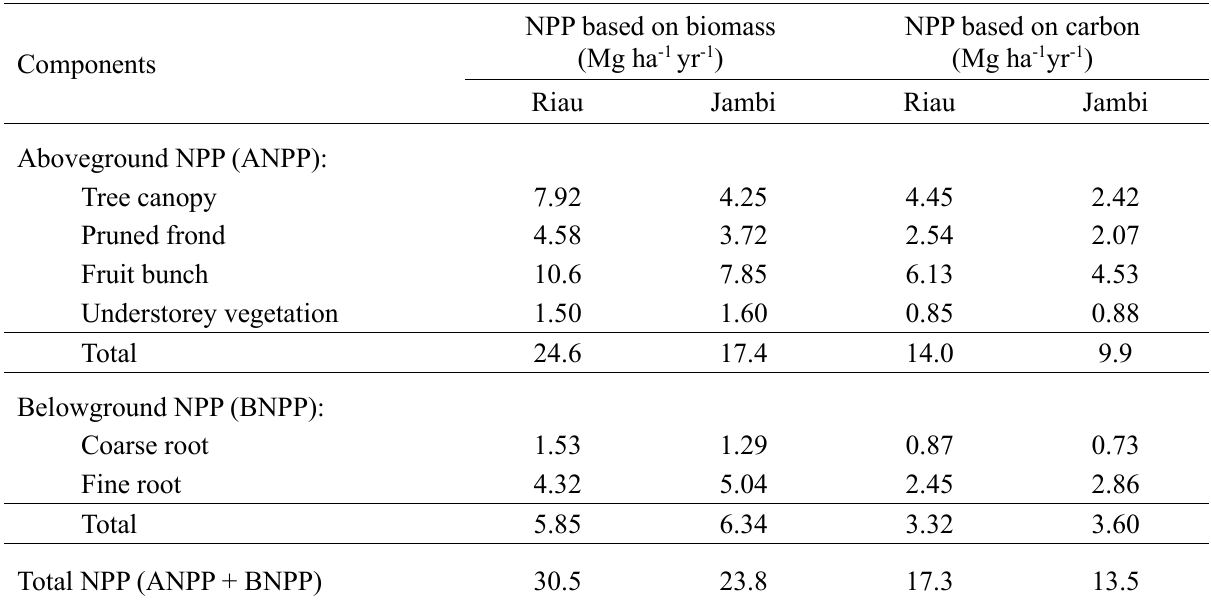
Table 7. Net primary production (NPP) based on biomass and carbon (adapted from Wakhid & Hirano 2021).